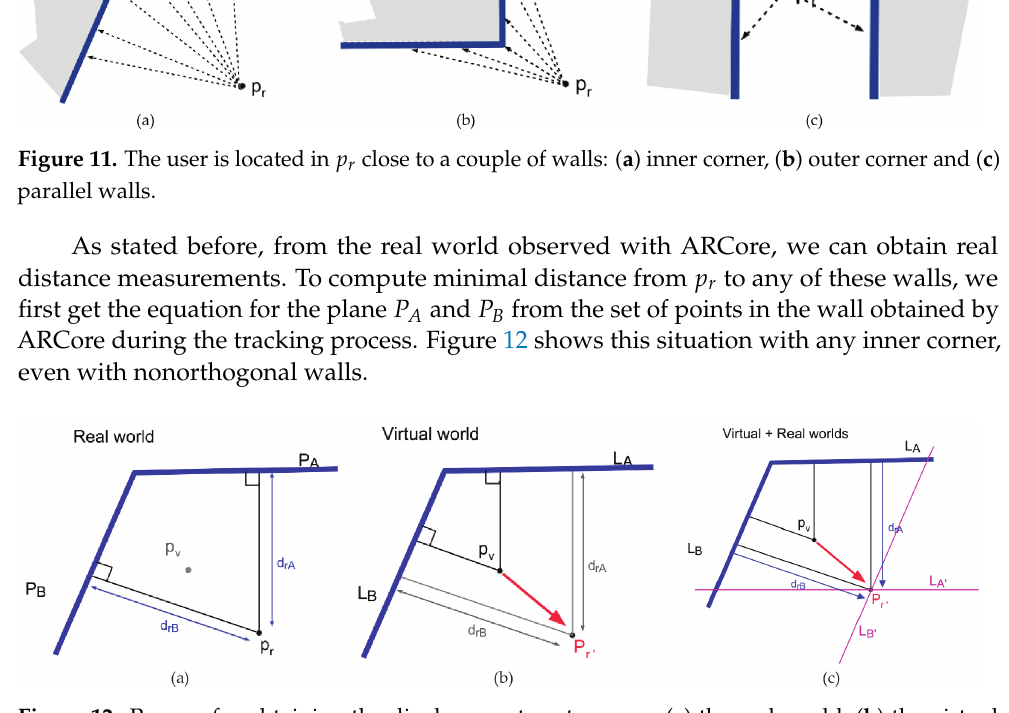
Figure 12. Process for obtaining the displacement vector p v p r : ( a ) the real world, ( b ) the virtual world and ( c ) the translation